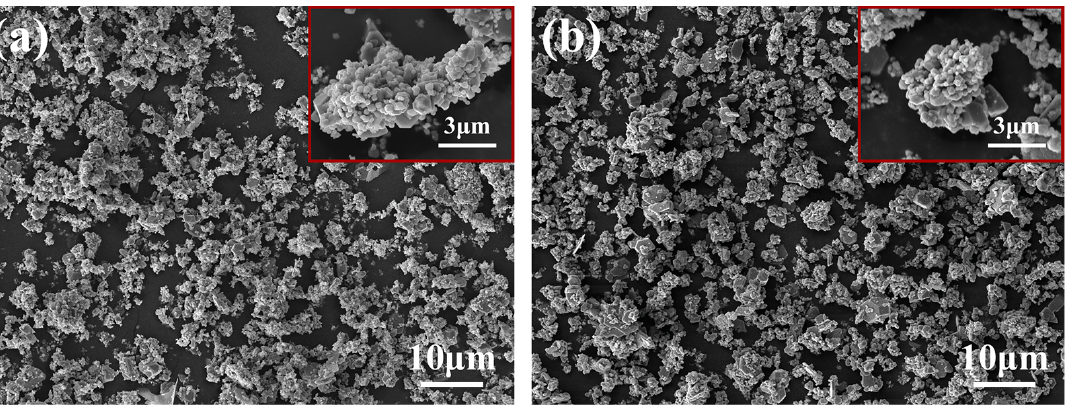
Figure 9. Microstructures of the extracted TiC from the as-cast samples: ( a ) Al-4Ti-1G (30 μ m) and ( b ) Al-4Ti-1G (4 μ m).